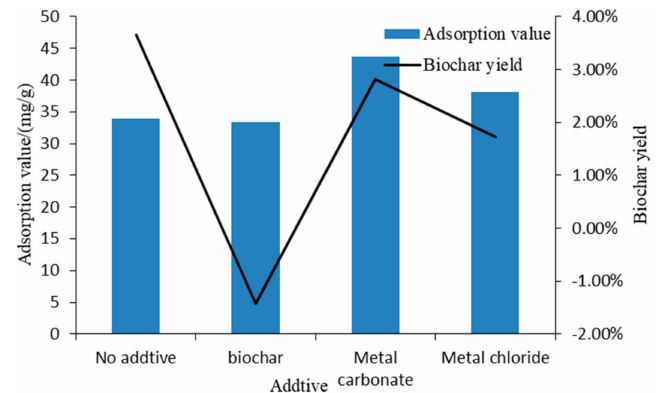
Figure 6. E ff ect of additive on the biochar yield and adsorbability.